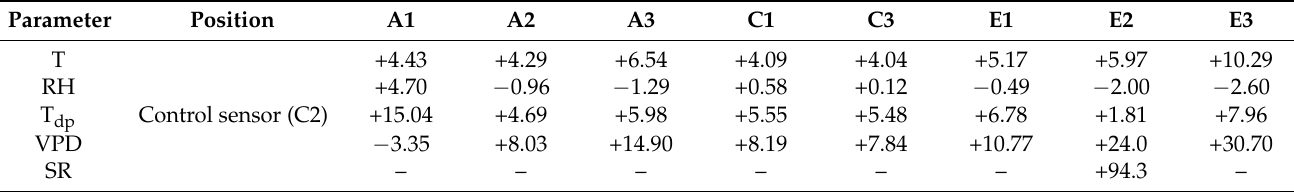
Table 5. Percentage change in parameter sum between the control sensor and the other sensors in SLG (single-layered greenhouse) T: air temperature; RH: relative humidity; T dp : dew point temperature; VPD: vapor pressure deficit; SR: solar radiation.